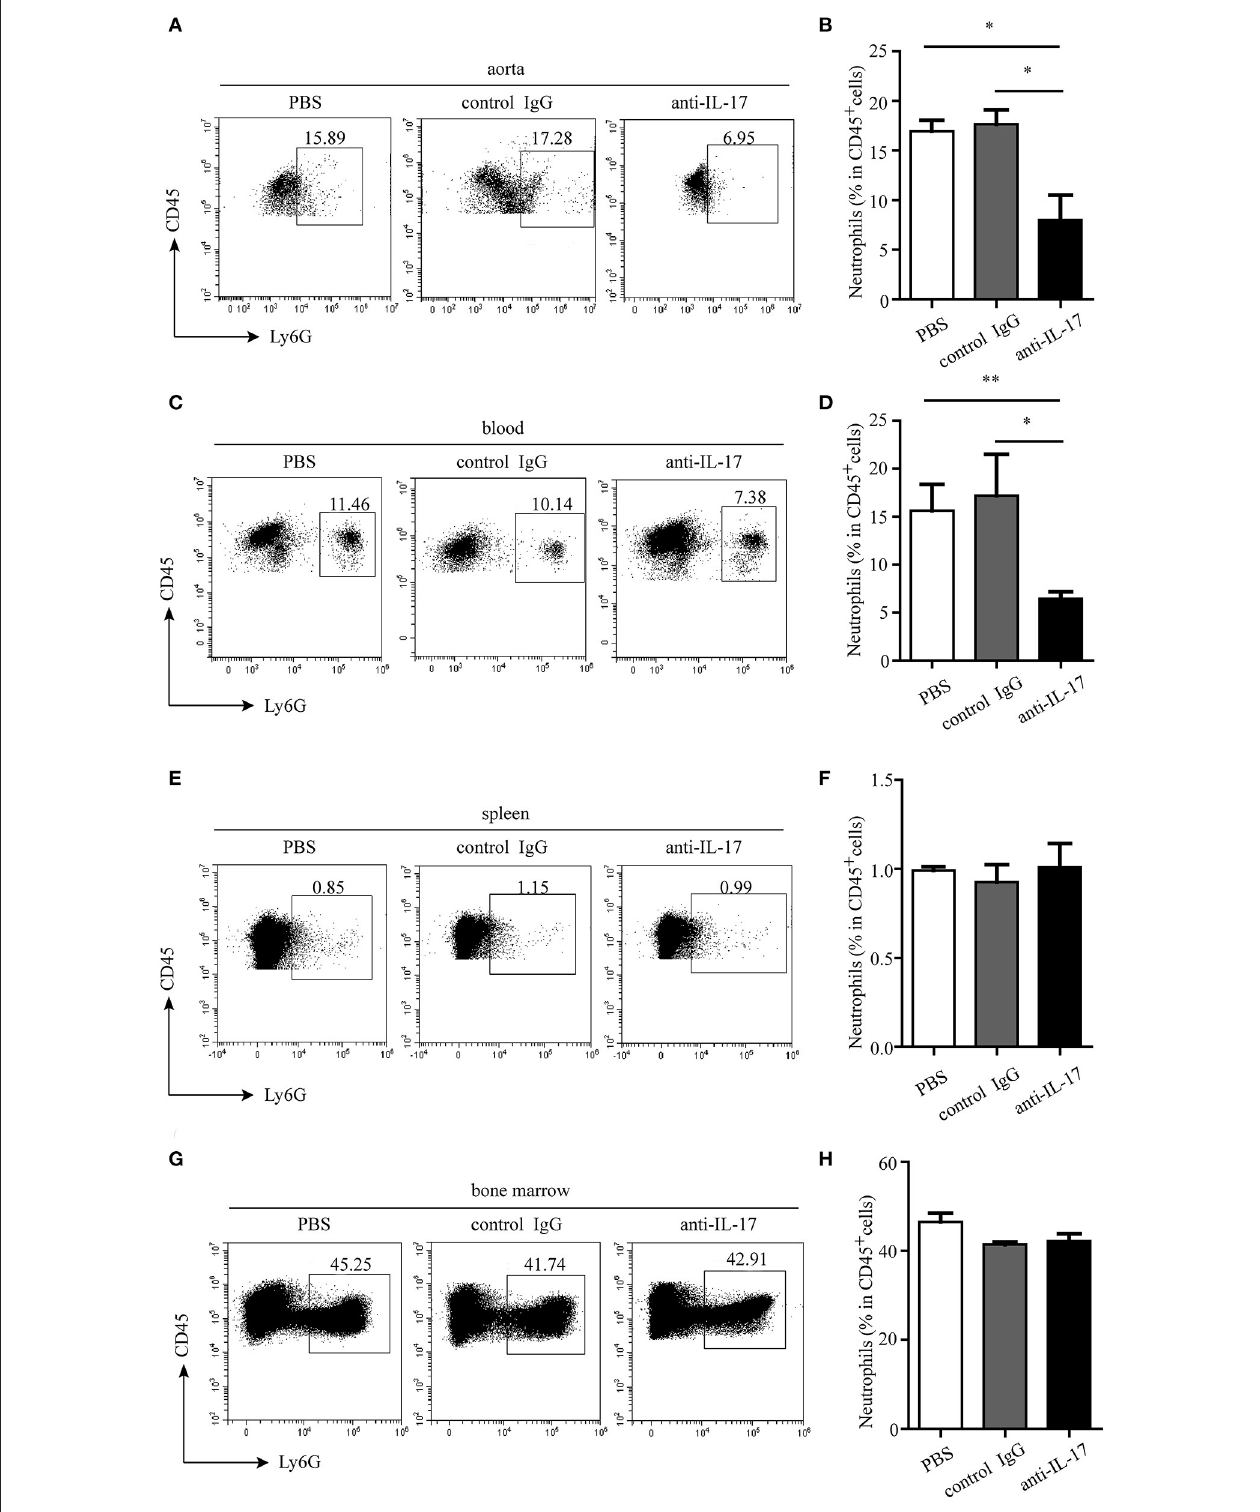
FIGURE 6 | Neutrophil infiltration in different organs after IL-17 blocking. Representative dot plots of neutrophil gating on CD45 + leukocytes and quantitative analysis of neutrophil percentages in (A,B) aorta, (C,D) blood, (E,F) spleen, and (G,H) bone marrow. * p < 0.05, ** p < 0.01.